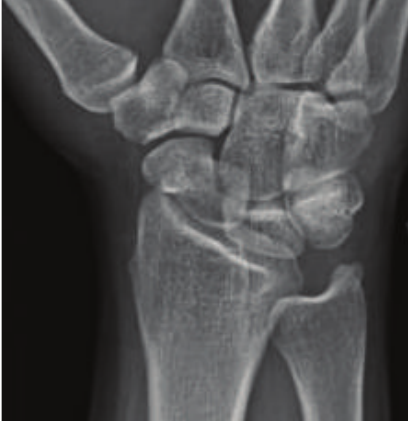
Figure 6: An oblique radiographic view obtained 6 weeks after presentation with no radiographic abnormality of the scaphoid.